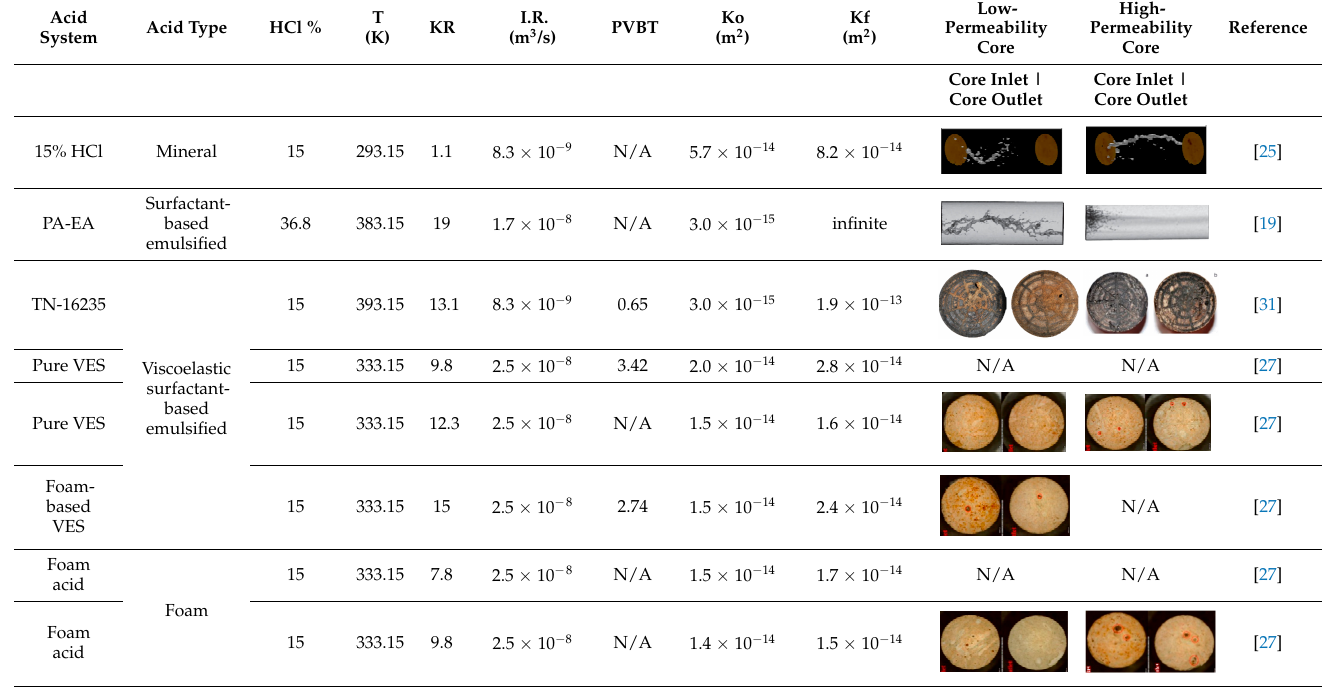
Table 2. Permeability increase on low-permeability cores after different acid treatments.